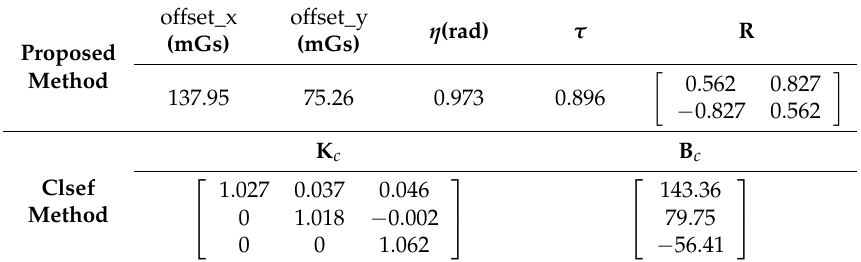
Table 1. Summary of the calibration parameters from the magnetometer calibration test.